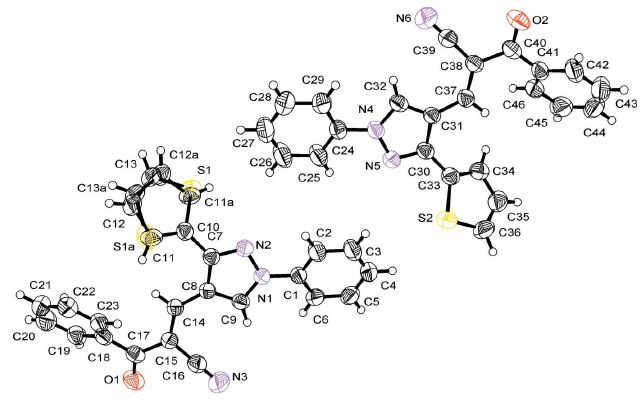
Figure 1 The asymmetric unit of the title compound, showing the atom-numbering scheme. Displacement ellipsoids of non-H atoms are drawn at the 50% probability